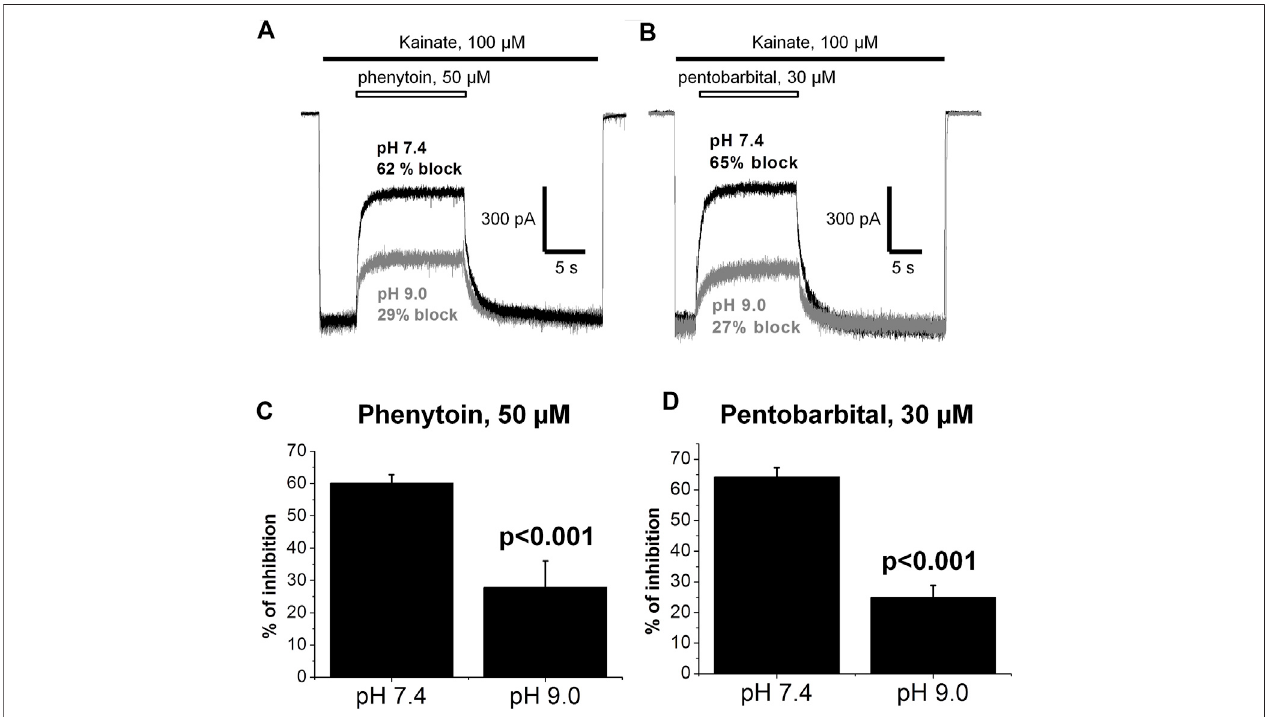
FIGURE 10 | The action of phenytoin and pentobarbital at pH 7.4 and 9.0. (A,B) Representative examples of CI-AMPARs inhibition by 50 µM phenytoin (A) and 30 µMpentobarbital (B) atpH7.4(blacktrace)and9.0(graytrace). (C,D) SummarizedresultsofCI-AMPARsinhibitionby50 µMphenytoin (C) and30 µMpentobarbital (D) at pH 7.4 and 9.0. Phenytoin and pentobarbital were more active at neutral than at more basic pH, which implies that their uncharged forms account for AMPAR